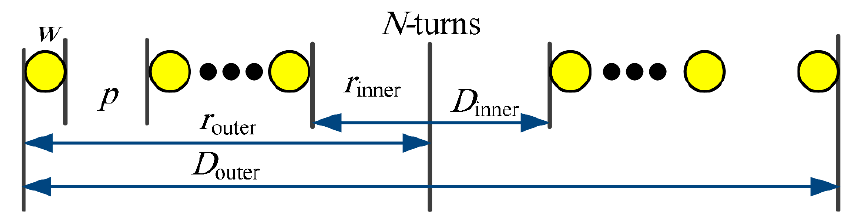
Figure 7. Cross-sectional shape of a circular flat spiral coil.